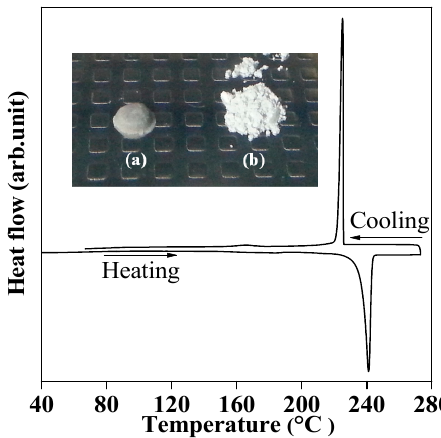
Figure 3. Differential scanning calorimetery (DSC) profile of the ball-milled mixture of LiNH 2 and KH. The DSC was performed under 0.5 MPa H 2 atmosphere in closed condition up to 270 °C, with heating rate of 5 °C/min. The inset shows the appearance of the ball-milled mixture of KH and LiNH 2 before ( b ) and after ( a ) the DSC measurement.